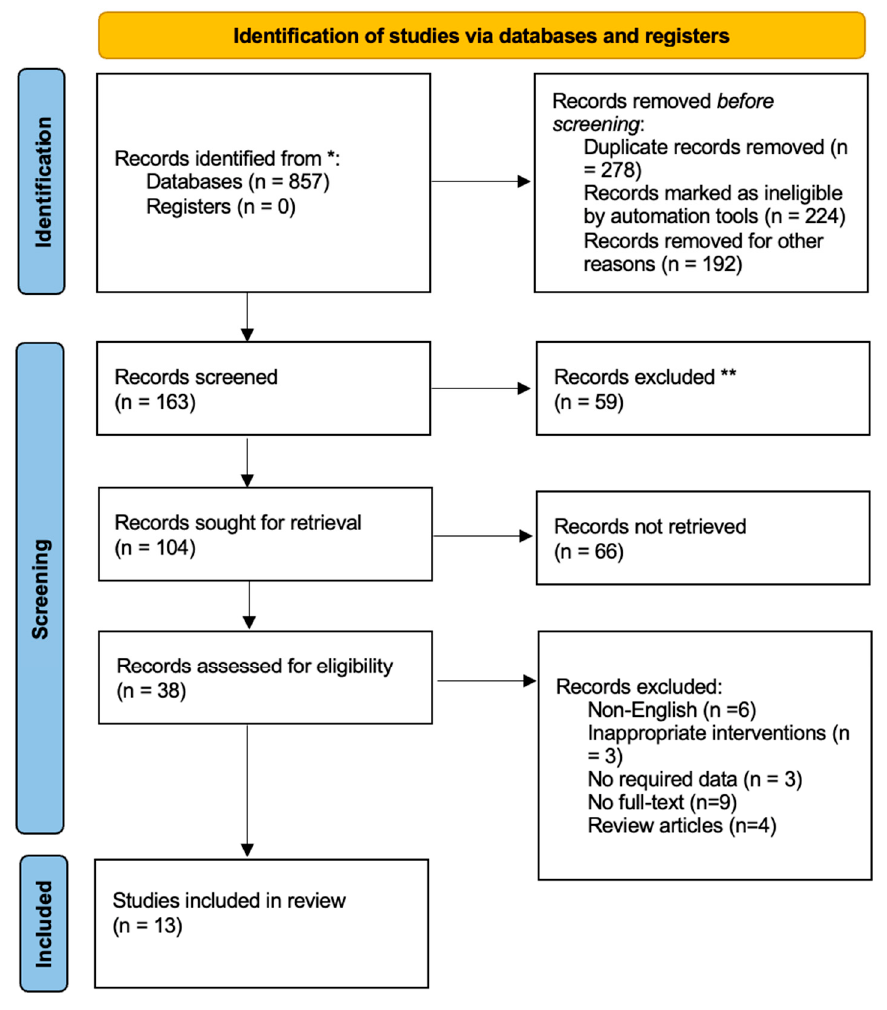
Figure 1. Flow diagram of selection of includes studies. * Consider, if feasible to do so, reporting the number of records identified from each database or register searched (rather than the total number across all databases/registers). ** If automation tools were used, indicate how many records were excluded by a human and how many were excluded by automation tools.